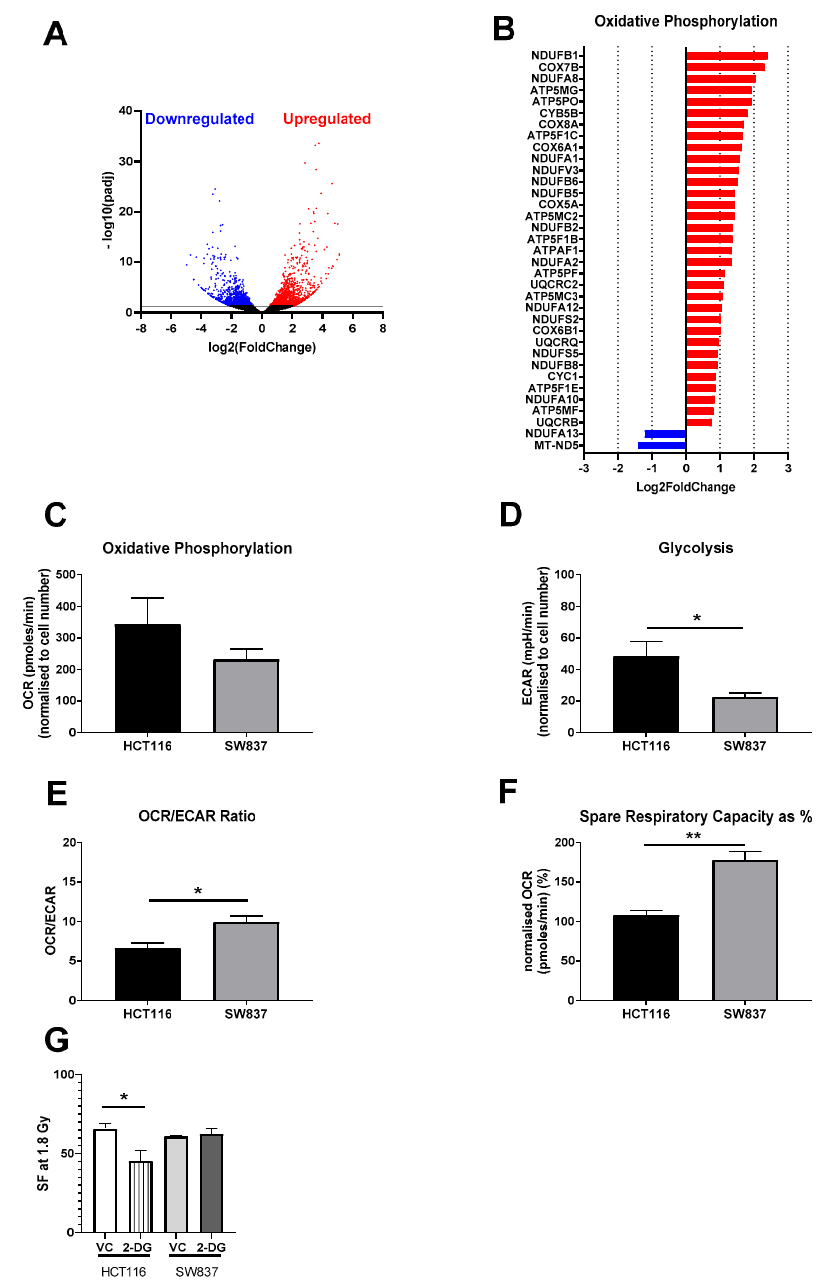
Figure 5. Transcriptomic and metabolic phenotype alterations in radioresistant SW837 cells. ( A ) Volcano plot demonstrating 2461 genes significantly altered in SW837 cells when compared to HCT116 cells. The y-axis shows the − log10 values ( p -adj), and the x-axis shows the log 2 values (fold changes). Dots in blue and red represent the significantly downregulated/upregulated genes (2461) in SW837 cells, respectively, when compared to HCT116 cells. Dots in black represent the genes which did not